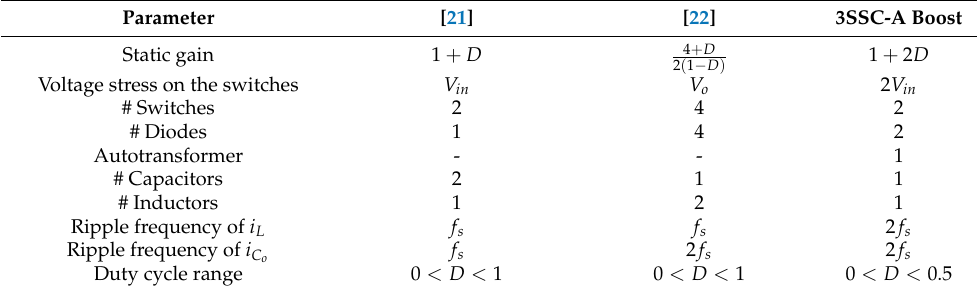
Table 2. Comparison among the 3SSC-A-based boost and other similar approaches in